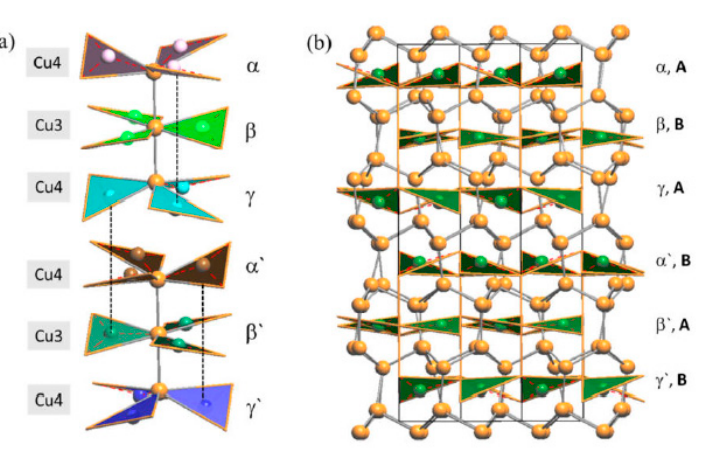
Figure 12. ( a ) A perspective view showing only the assembling of the six different layers of ‘Cu 3 As’-units in the LT—Cu 3 As structure. ( b ) Perspective view of the whole unit cell of the LT structure.